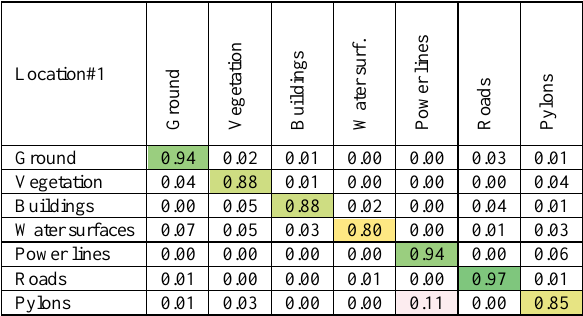
Table 3 . Confusion matrix after monosource classification of